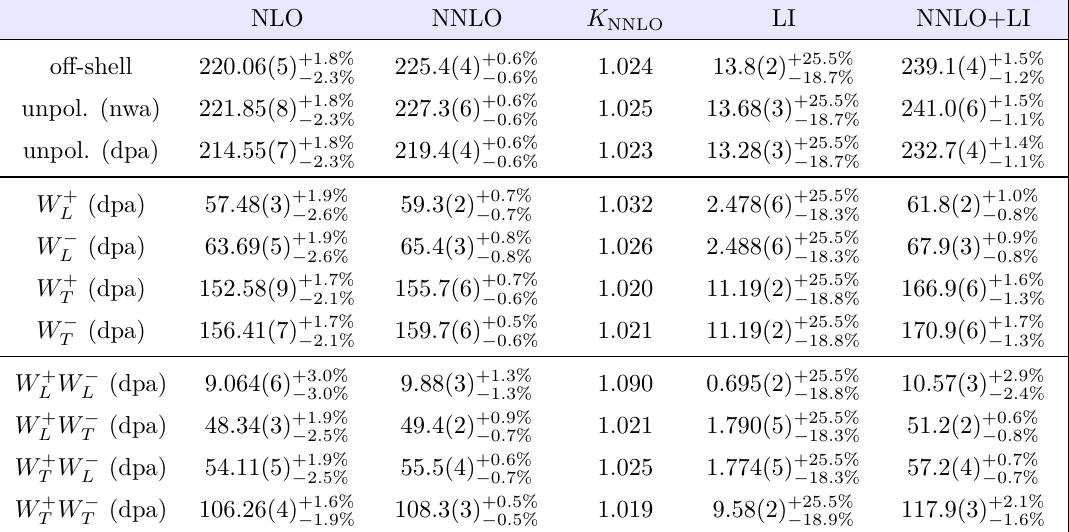
Table 1 . Total cross-sections (in fb) for the unpolarised, singly-polarised and doubly-polarised W + W − production at the LHC. Unpolarised calculation is performed in three ways: full off-shell, and using approximations: DPA, NWA. Polarised setups are calculated using DPA. Uncertainties are computed with 7-point scale variations by a factor of 2 around the central scale. K -factors are presented as ratios of NNLO QCD (without LI) over NLO integrated cross-sections. NNLO+LI represents the full O ( α 2 ) s